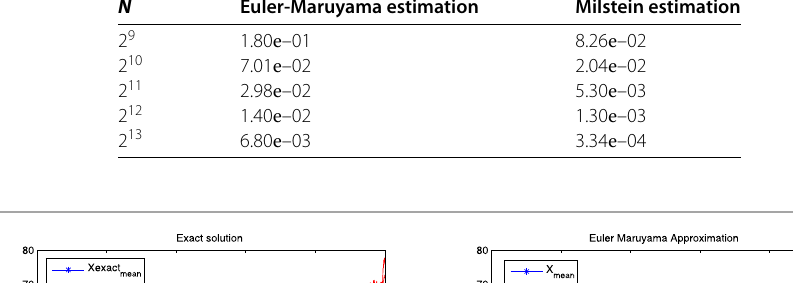
In Table 2, the mean square error